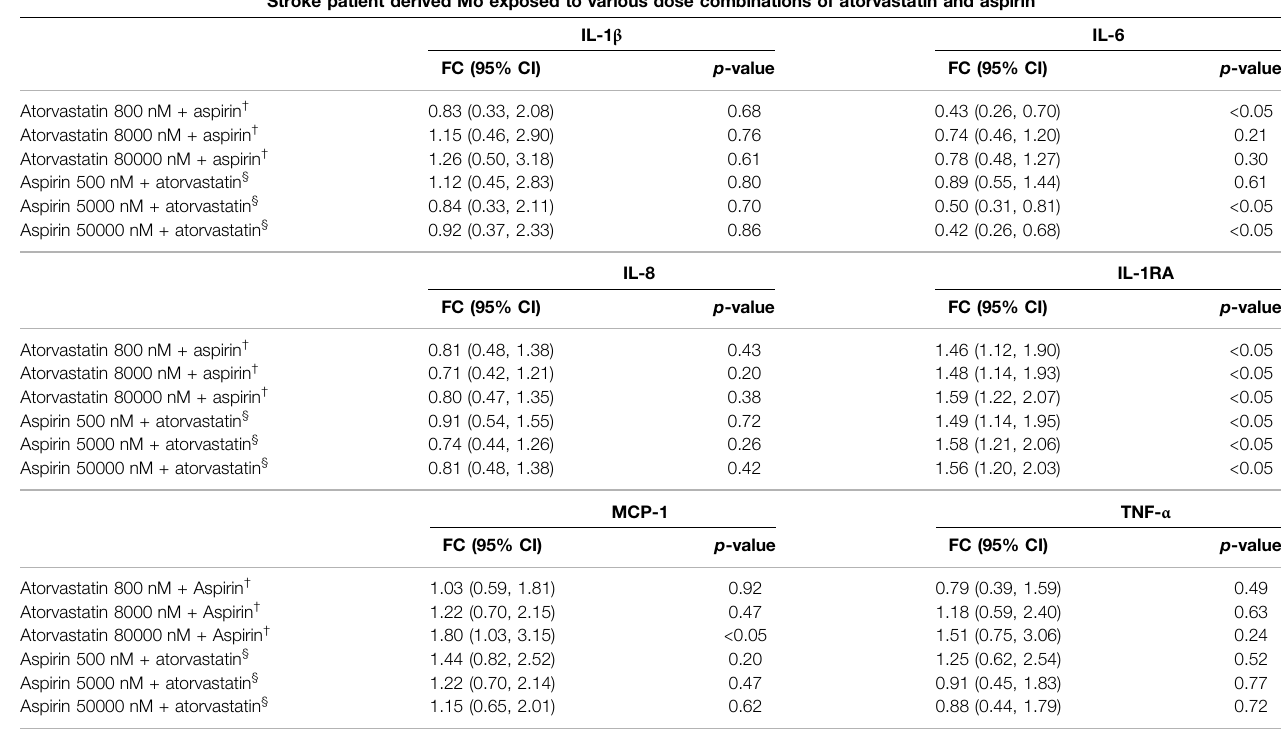
Frontiers in Pharmacology |